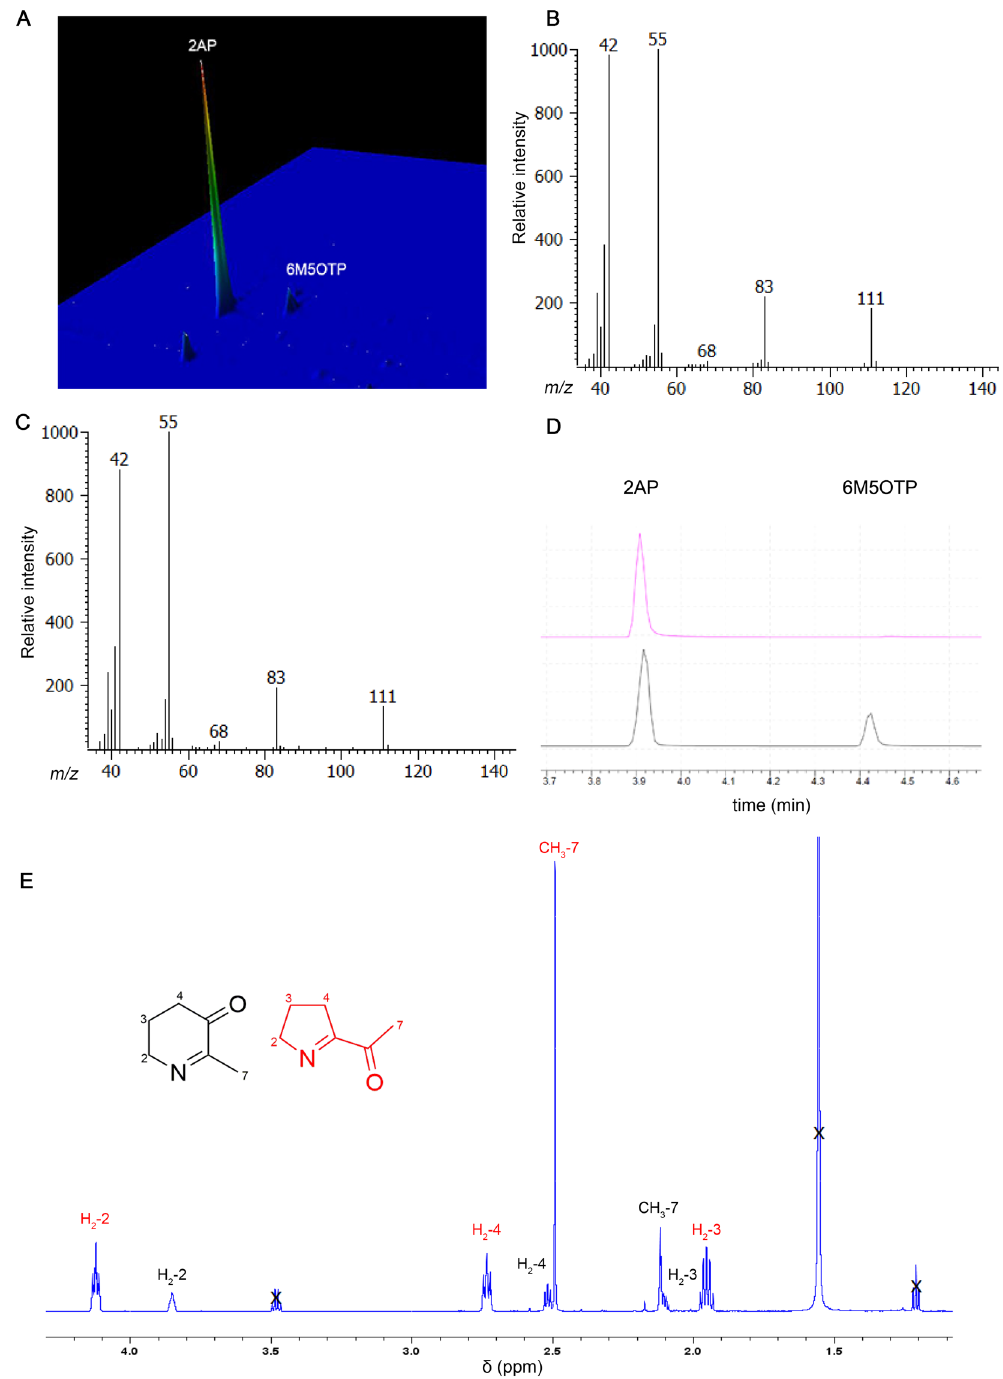
Figure 2. Identification of Analyte 5 as (6M5OTP). ( A ) GC × GC-TOF-MS 3D chromatogram of synthesised 2AP standard showing 2AP (RT: 627.5 s, 1.025 s) and 6M5OTP (RT: 707.5 s, 1.27 s). MS Electron ionisation fragmentation pattern of Analyte 5 detected by GC × GC-TOF-MS ( B ) synthesised 2 AP standard, and ( C ) rice. ( D ) GC-MS trace comparison of ratio between 2AP and 6M5OTP before (above) and after acid-base extraction (below). ( E ) Expansion of the 1 H NMR of 2AP (red) and 6M5OTP (black). Solvent peaks are denoted in